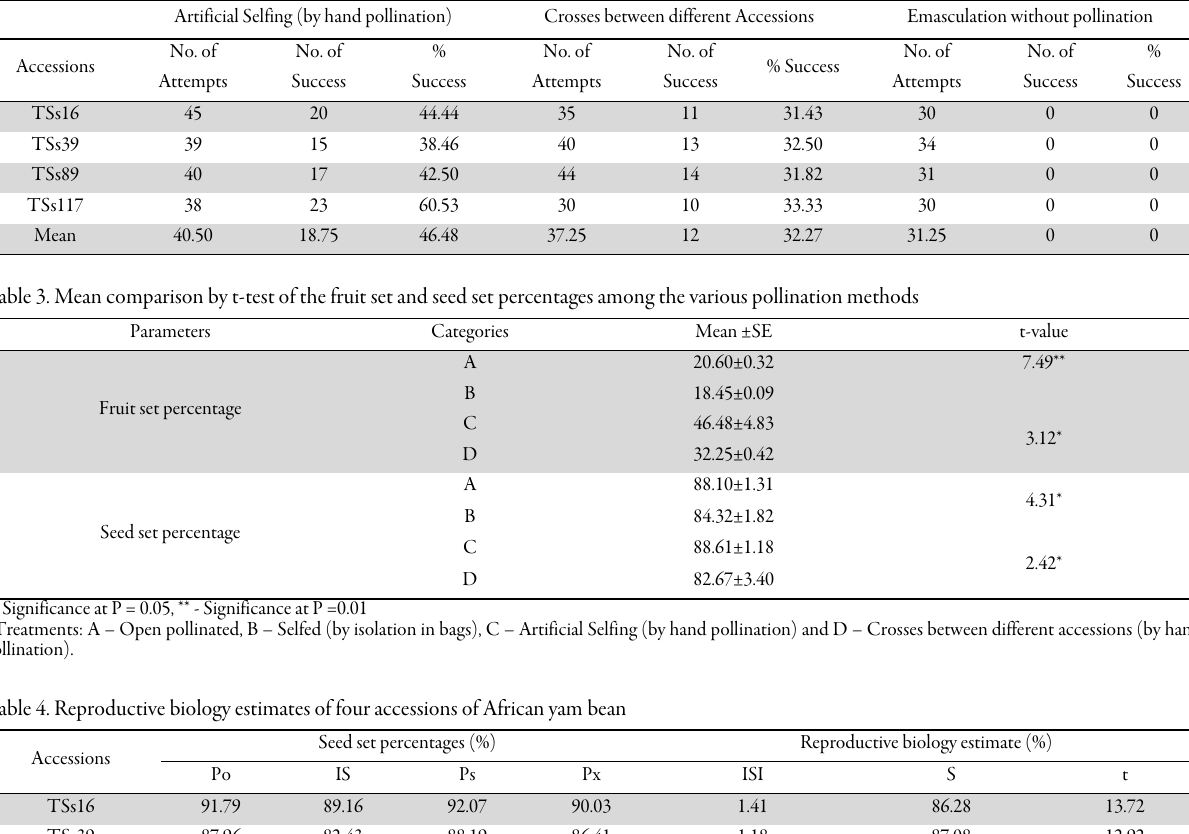
Table 2. Number of attempted crosses, corresponding number and percentages of successes achieved for various pollination method in African yam bean Artificial Selfing (by hand pollination) Crosses between different Accessions Emasculation without pollination No. of Accessions Attempts